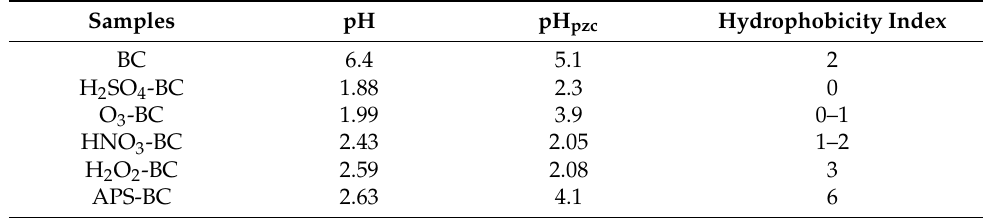
Table 2. The pH, pH pzc , and hydrophilicity of biochar samples.